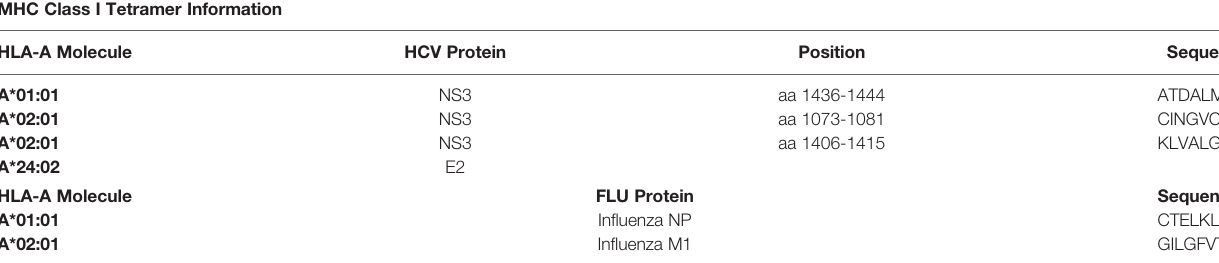
TABLE 2 | HLA multimeric complex information. MHC Class I Tetramer Information